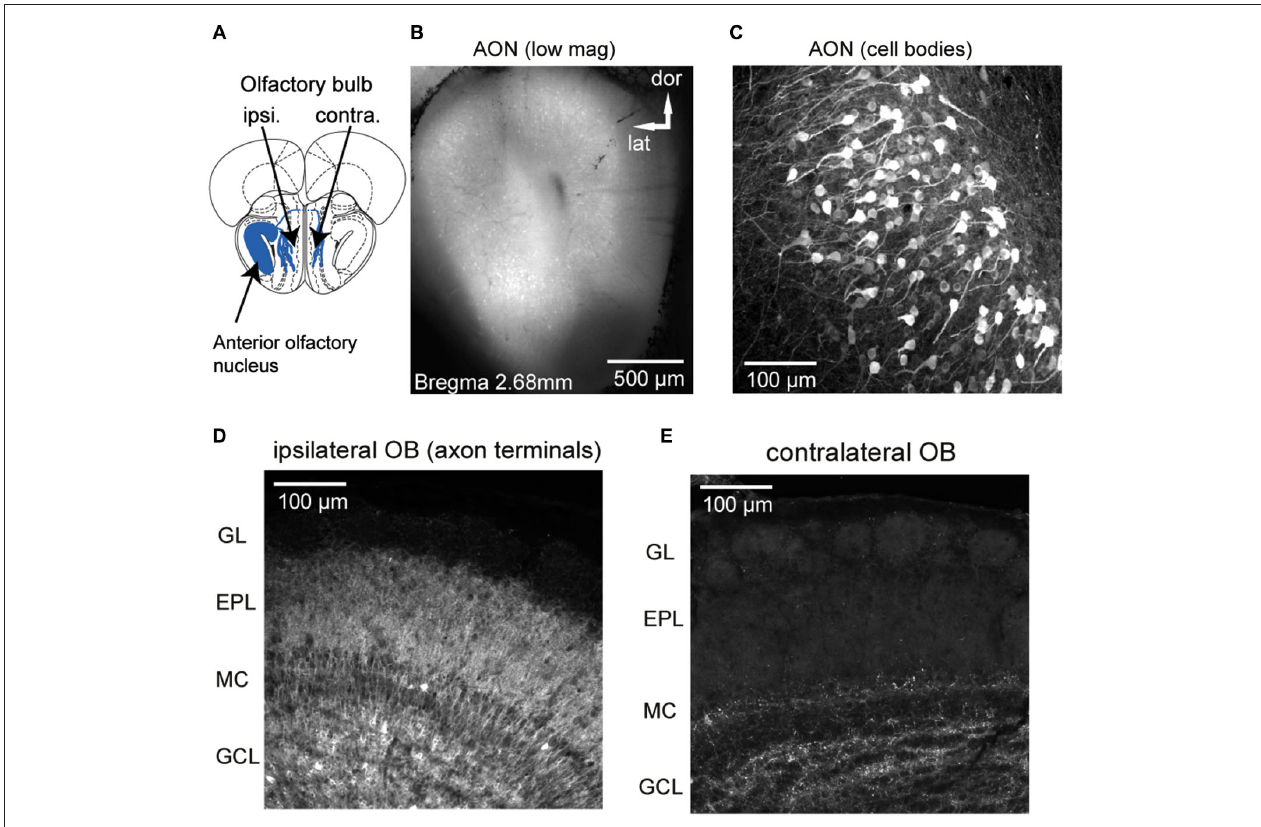
morphology of expressing neurons. (D and E) Confocal stack from the ipsilateral (D) and contralateral (E) dorsal OB displaying AON terminals ending in different layers. The ipsilateral OB shows expression predominately in the granule cell and external plexiform layers whereas in the contralateral OB fewer fibers in granule cell and deep external plexiform layer are labeled. GL: glomerular layer, EPL: external plexiform layer, MC: mitral cell layer, GCL: granule cell